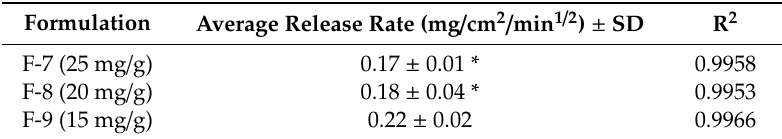
Table 4. The rate of penetration of ACTH through pig skin from hydrogel ointment taking into account the dependence of the amount permeated to the surface in cm 2 w on the square root of time (using Higuchi’s model), (n = 5); * p <